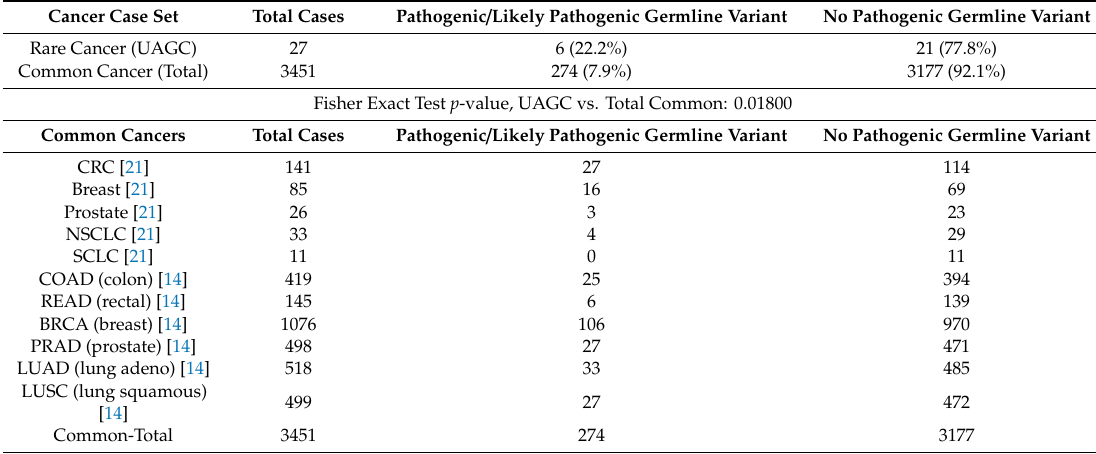
Table 3. Inherited pathogenic variants in common and rare